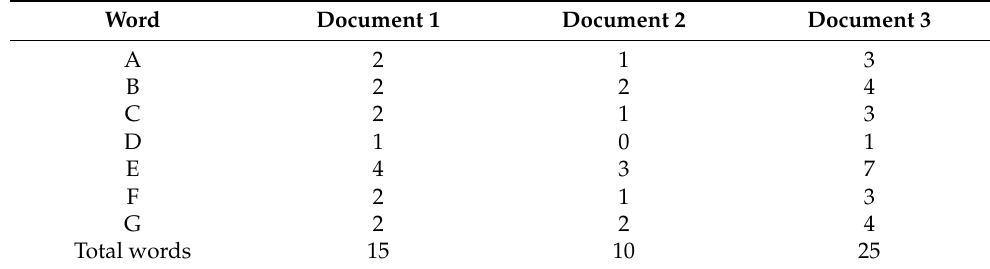
Table 3. Number of feature words in the document.